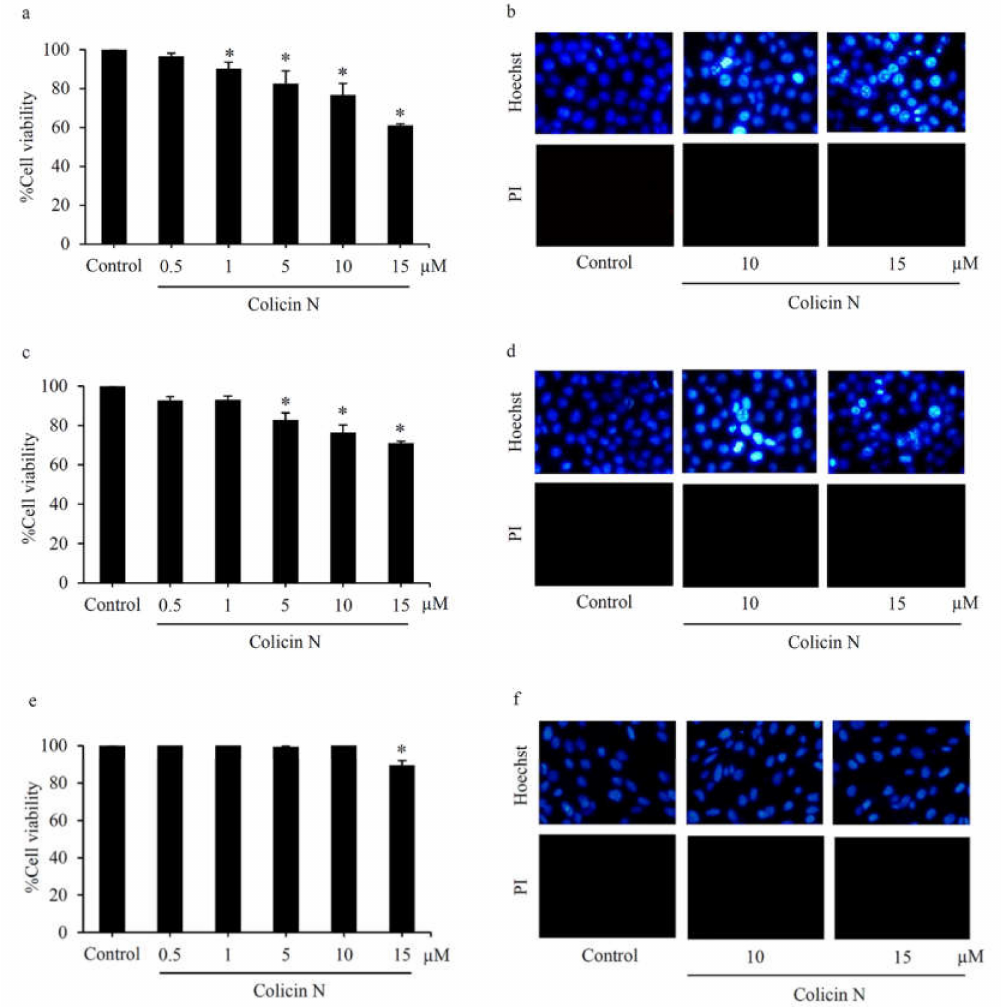
Figure 5. MTT viability assay of ( a ) H292 and ( c ) H23 cells, depicting anticancer activity of colicin N (5–15 µ M) against various types of human lung cancer cells. ( e ) Meanwhile, culture with 0.5–10 µ M of colicin N for 24 h caused no alteration of %cell viability in human dermal papilla DPCs cells. Mode of cell death detected via co-staining of Hoechst33342 / propidium iodide (PI) presents apoptosis in lung cancer ( b ) H292 and ( d ) H23 cells treated with 10–15 µ M colicin N. ( f ) Neither apoptosis nor necrosis was observed in DPCs cells incubated with colicin N (10–15 µ M). Values are means of the independent triplicate experiments ± SD. * p ≤ 0.05 versus non-treated